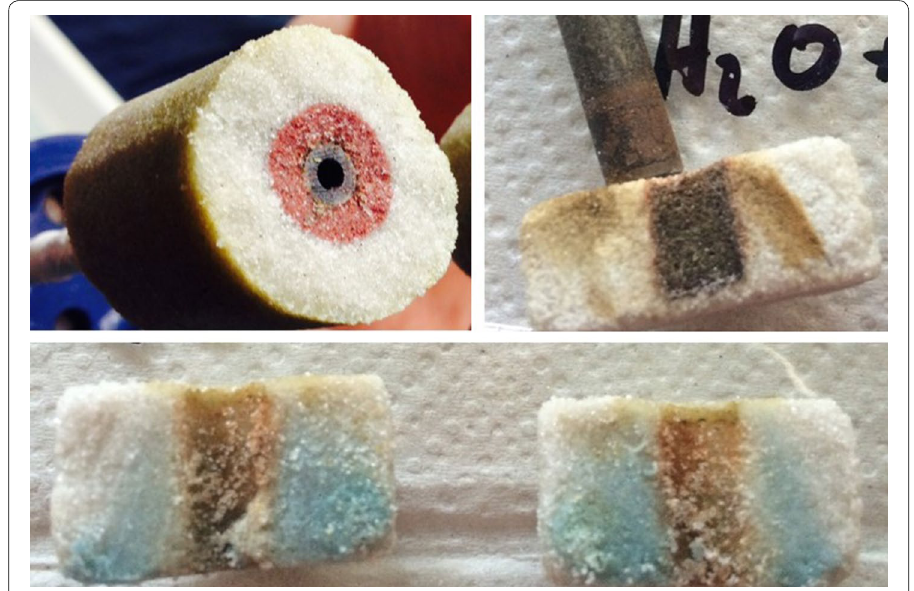
Fig. 4 Rock samples cut open after the reaction of carbon steel with synthetic Cu-containing fluid: Top left oxic experiment (O) opened immediately after removal from the brine. Top right anoxic experiment D with no additional chloride salt; Bottom experiment C: anoxic with brine. Pictures of experiment C and D were taken some weeks after the